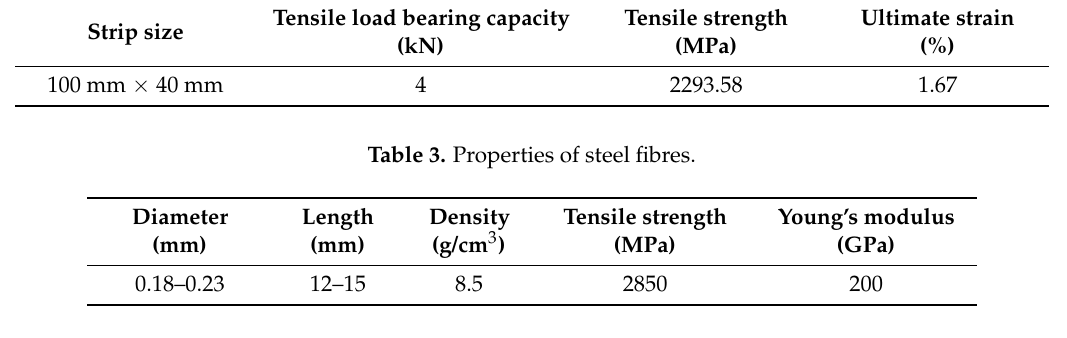
Table 4. Mixture of the cementitious matrix.